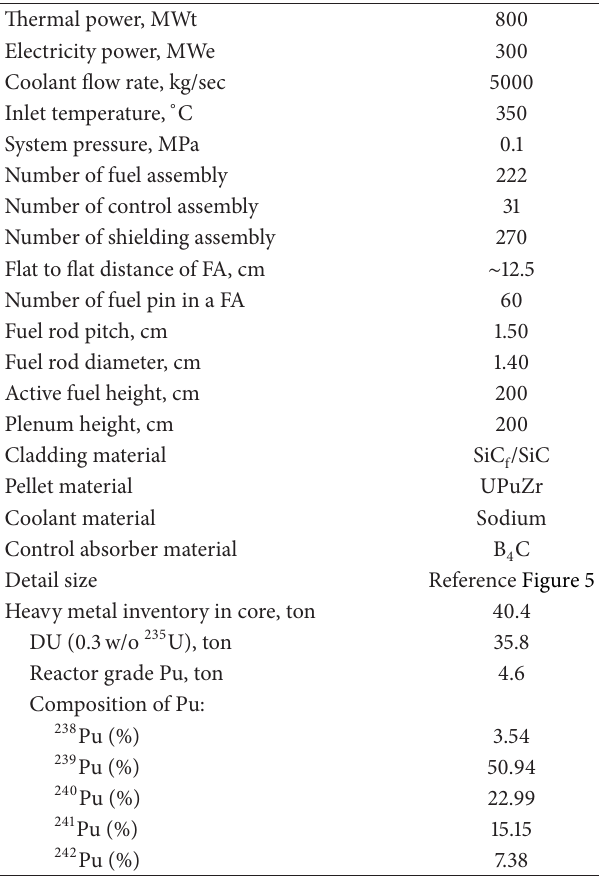
Table 1: General parameters for reference core of